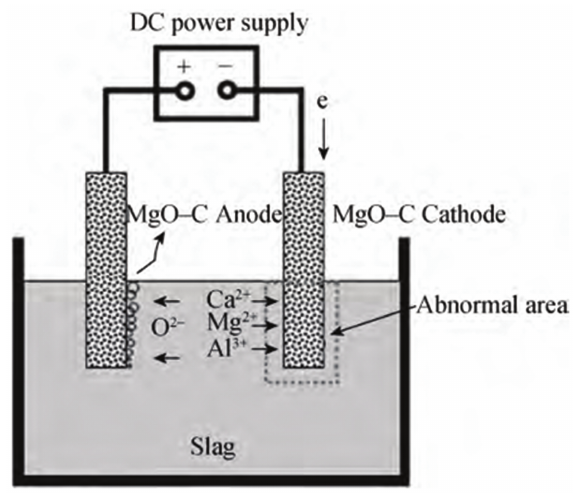
Figure 8: Principle of induced electro-deposition